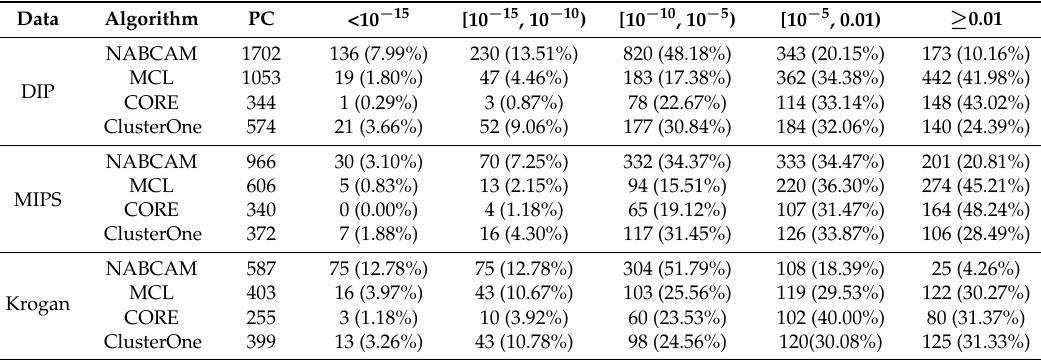
Table 2. Functional enrichment analysis of complexes detected on different datasets.